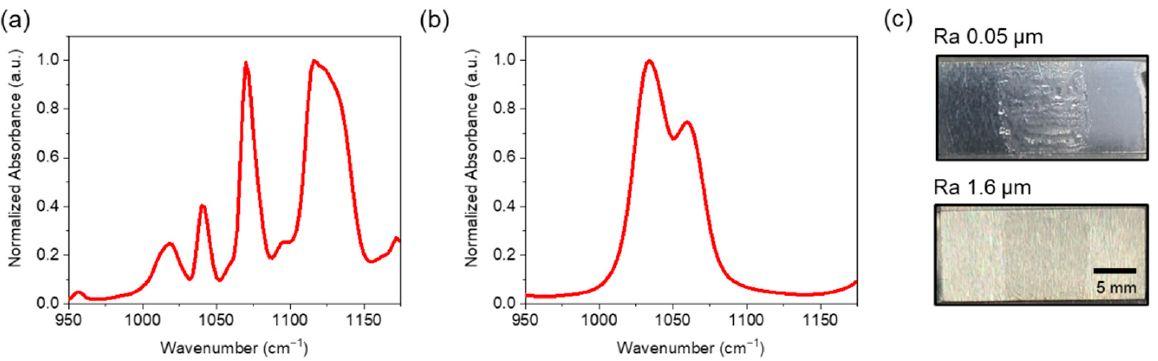
Figure 3. Normalized absorbance spectra of the analyte chemicals of ( a ) DEP and ( b ) DMMP in the EC-QCL operational wavenumber range. ( c ) Photograph images of DEP with surface density of 4 g/m 2 distributed on the substrates formed by grinding.